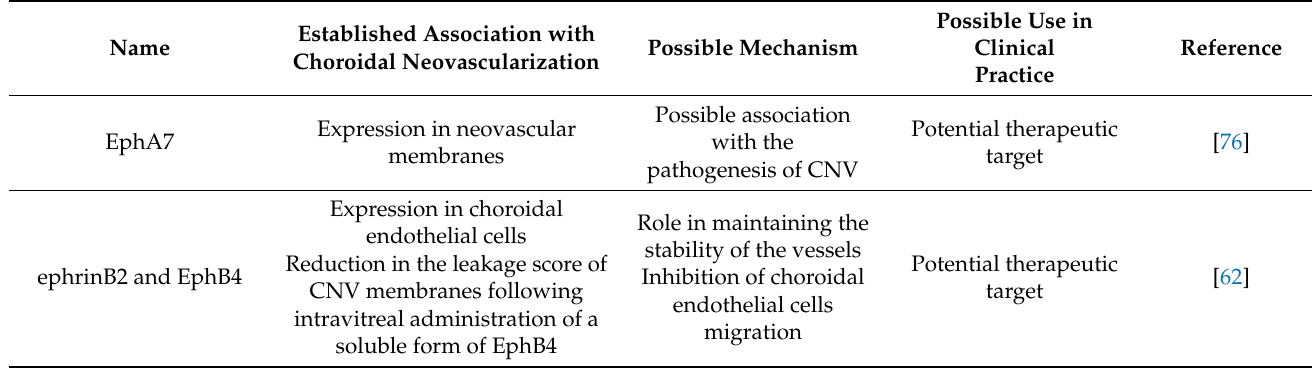
Table 4. A summary of the identified associations of Eph and ephrins with choroidal neovascularization.